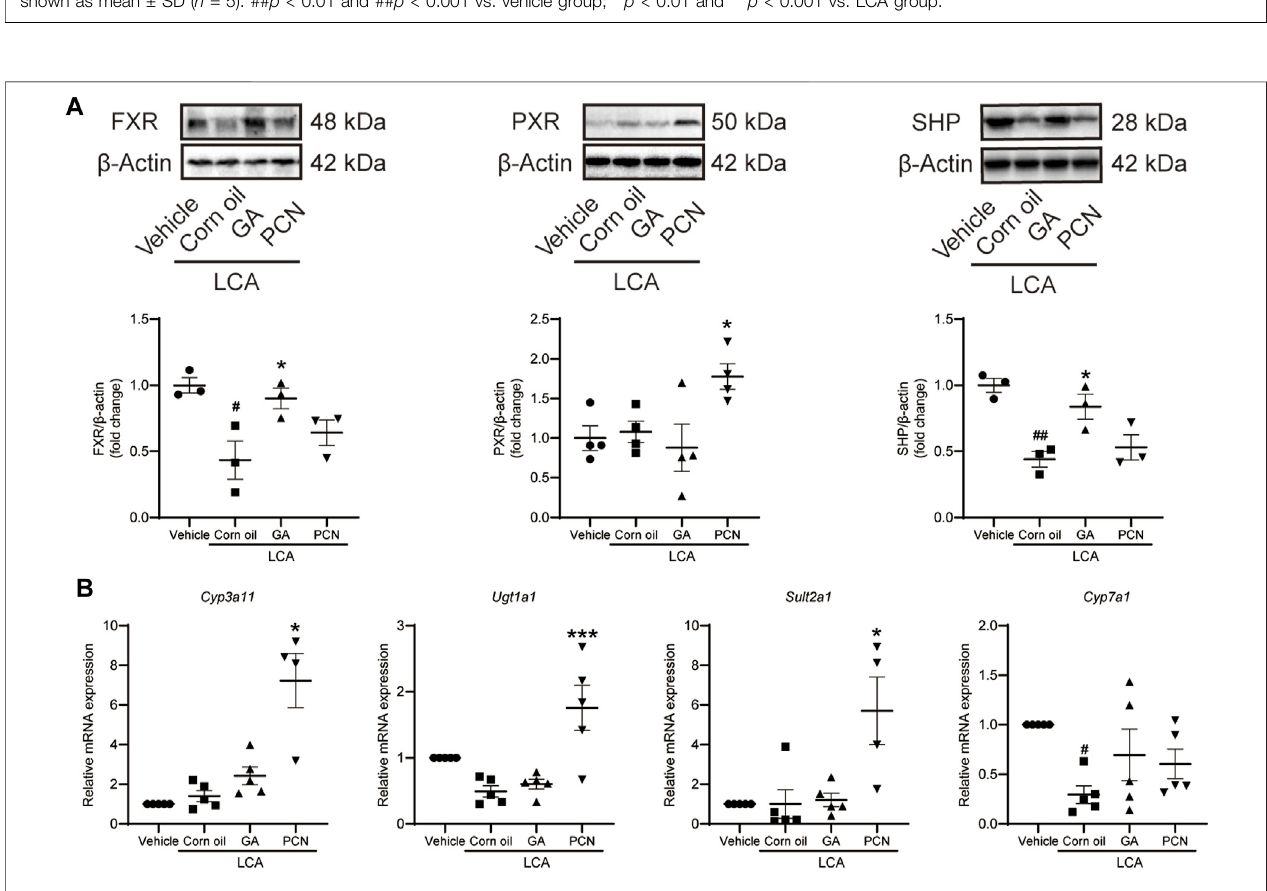
FIGURE 5 | GA regulated hepatic expression of FXR, PXR, and metabolic enzymes involved in BA detoxi fi cation in LCA-induced cholestatic liver injury. (A) Protein levels of FXR, PXR, and SHP were detected by Western blot analysis; (B) mRNA levels of Cyp3a11 , Ugt1a1 , Sult2a1 , and Cyp7a1 were determined by RT-qPCR. Data are presented as mean ± SD ( n = 5). # p < 0.05 and ## p < 0.01 vs. vehicle group; p p < 0.05 and ppp p < 0.001 vs. LCA group.